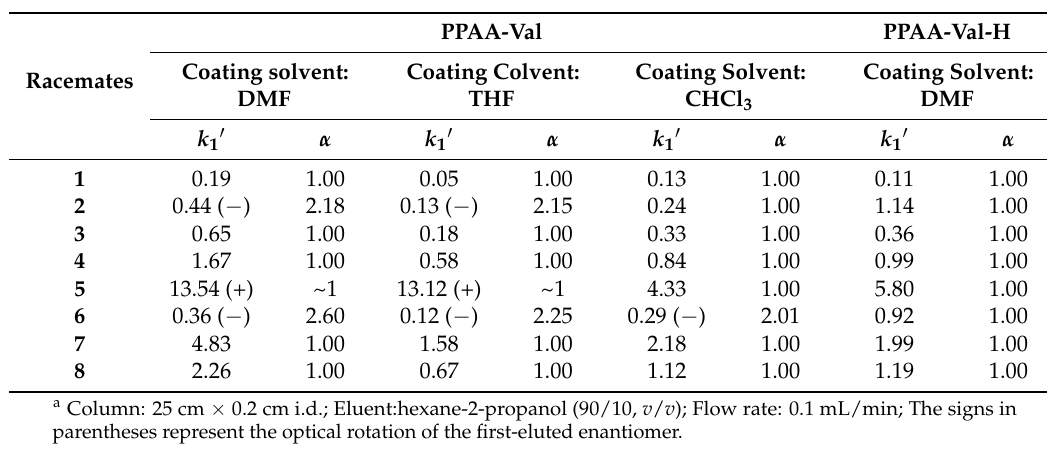
Table 3. Resolution of racemates on PPAA-Val and PPAA-Val-H a .